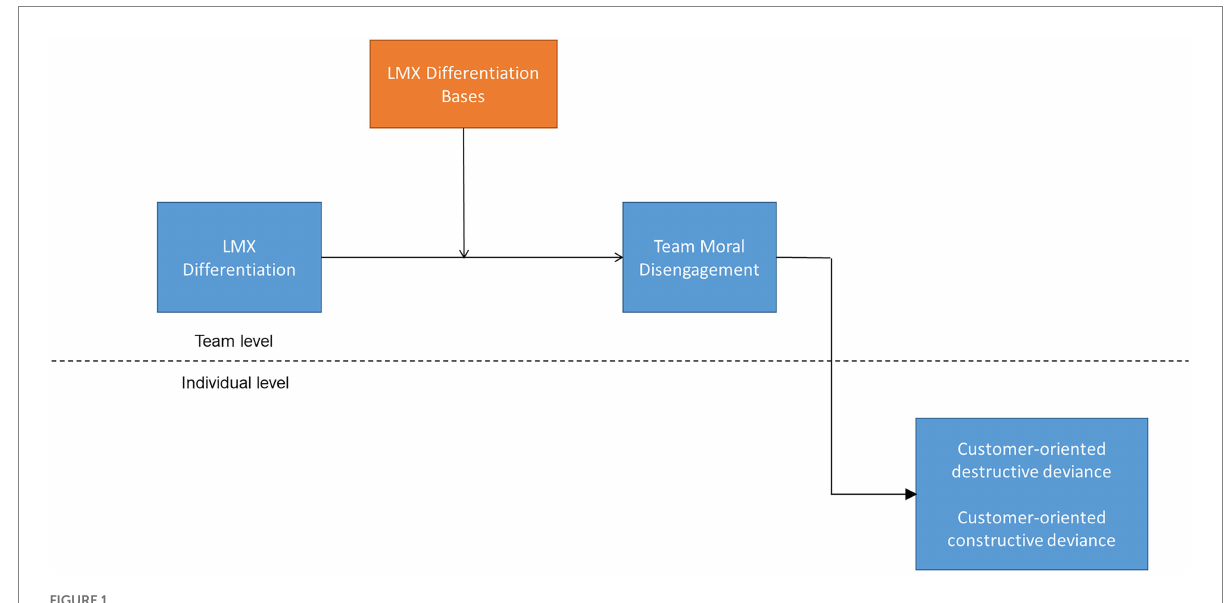
FIGURE 1 Hypothesized